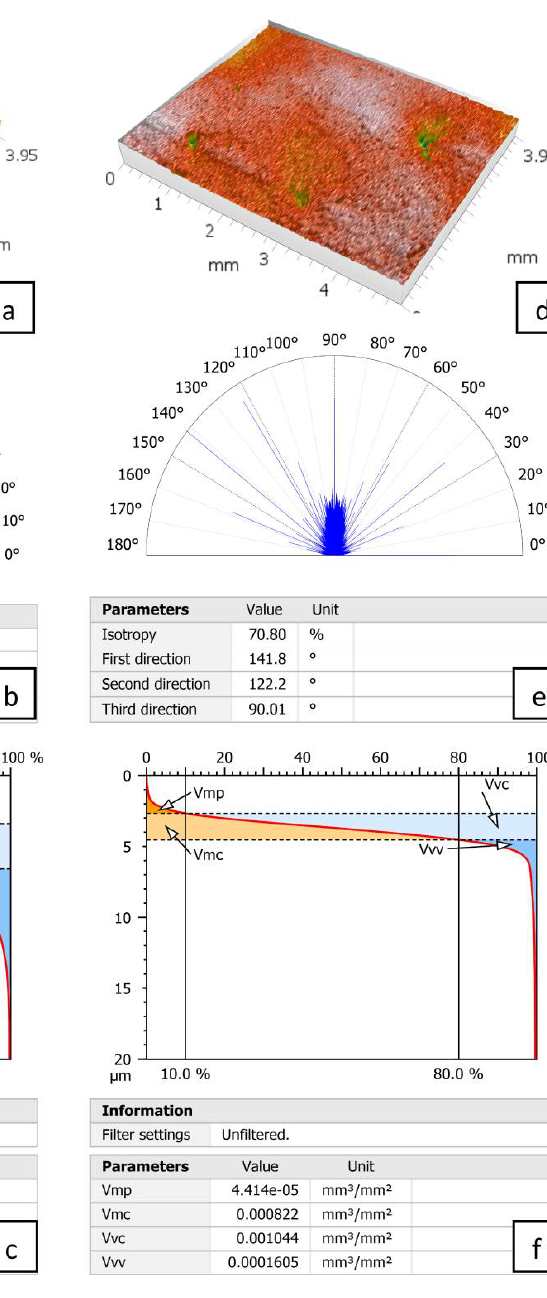
they are affected by the BF tools (Figure 8f). In this case, further conditioning can cause damage due to microfatigue and microcracking phenomena.